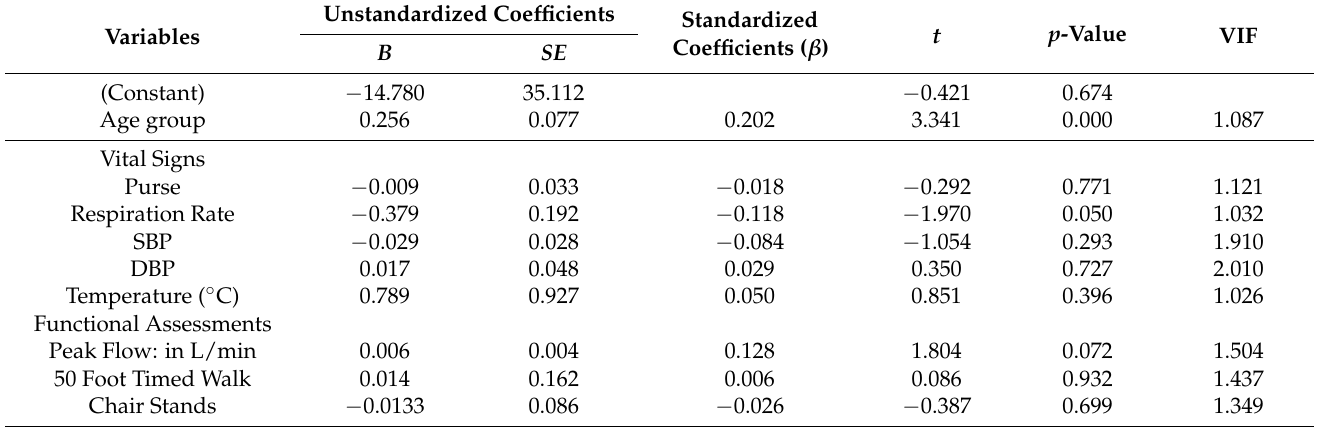
Table 4. Unstandardized regression coefficient ( B ), standardized coefficient ( β ), and standard error ( SE ) for age and health capabilities on life satisfaction